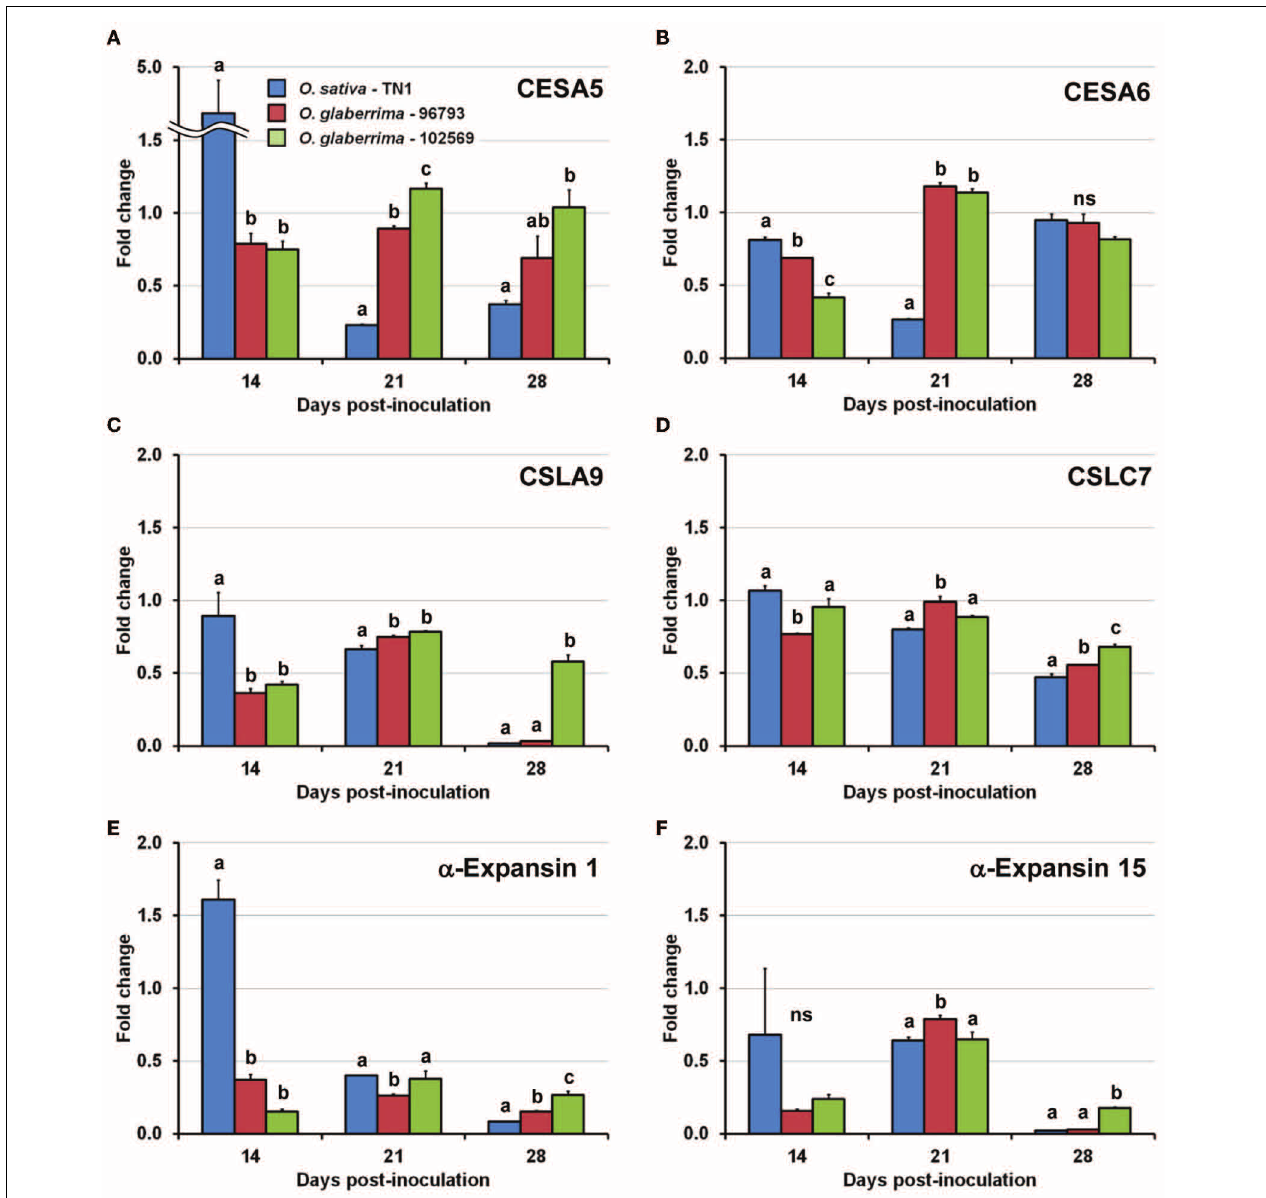
FIGURE 3 | Changes in expression of cell wall-related genes after infection with Rice tungro spherical virus (RTSV) in plants of Oryza glaberrima and O. sativa examined by real-time RT-PCR. Vertical bars and vertical lines indicate means and standard errors of mean, respectively, for the fold changes in expression of genes for (A) cellulose synthase A5 (CESA5), (B) cellulose synthase A6 (CESA6), (C) cellulose synthase-like A9 (CSLA9), (D) cellulose synthase-like C7